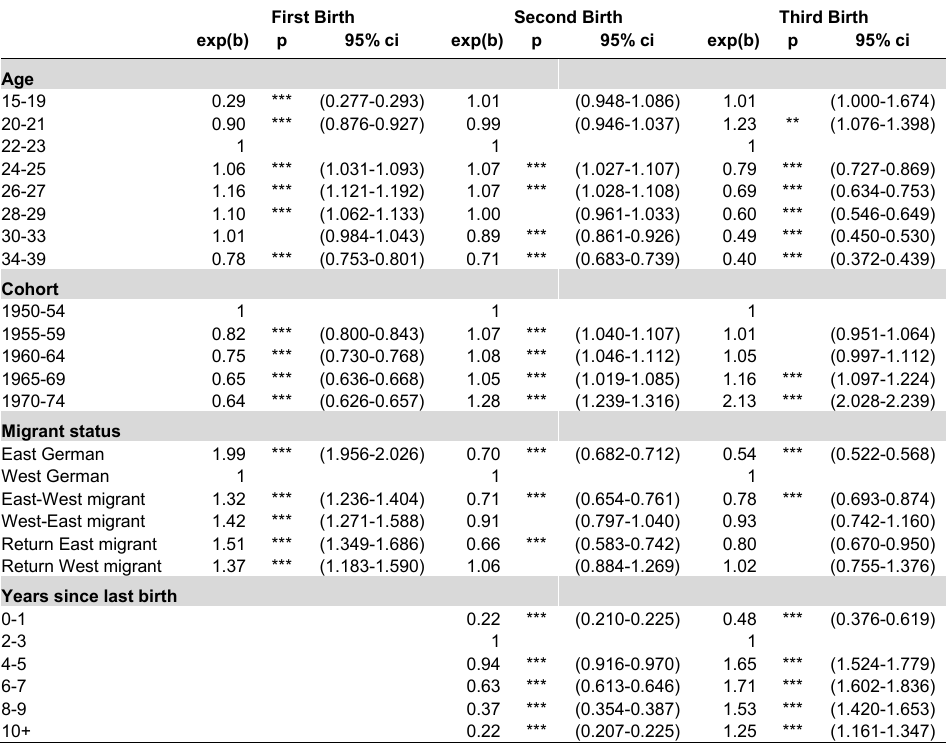
Table A3 : Results from piecewise constant model, relative